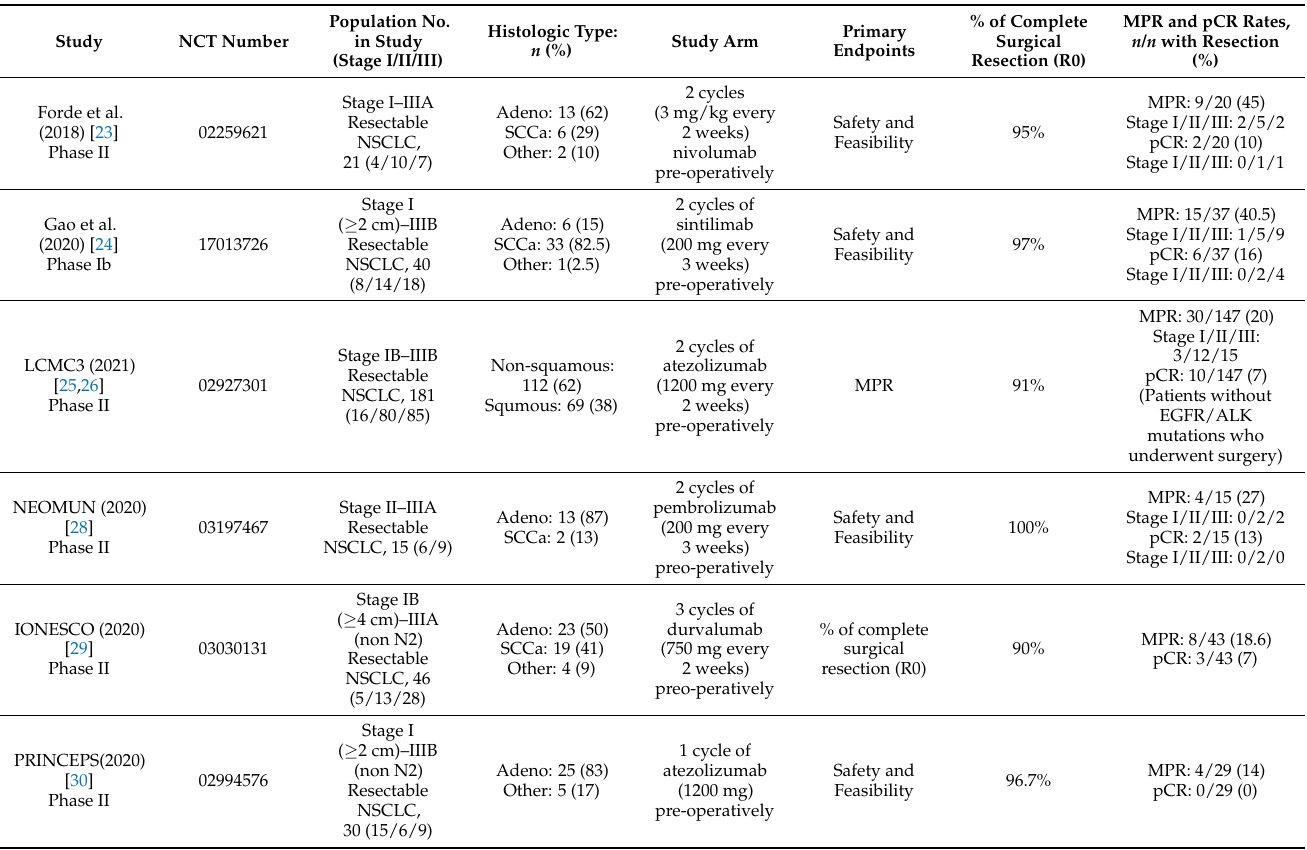
Table 1. Summary of Efficacy Outcomes from Neaodjuvant Single Agent Immunotherapy Trials with Reported Results.